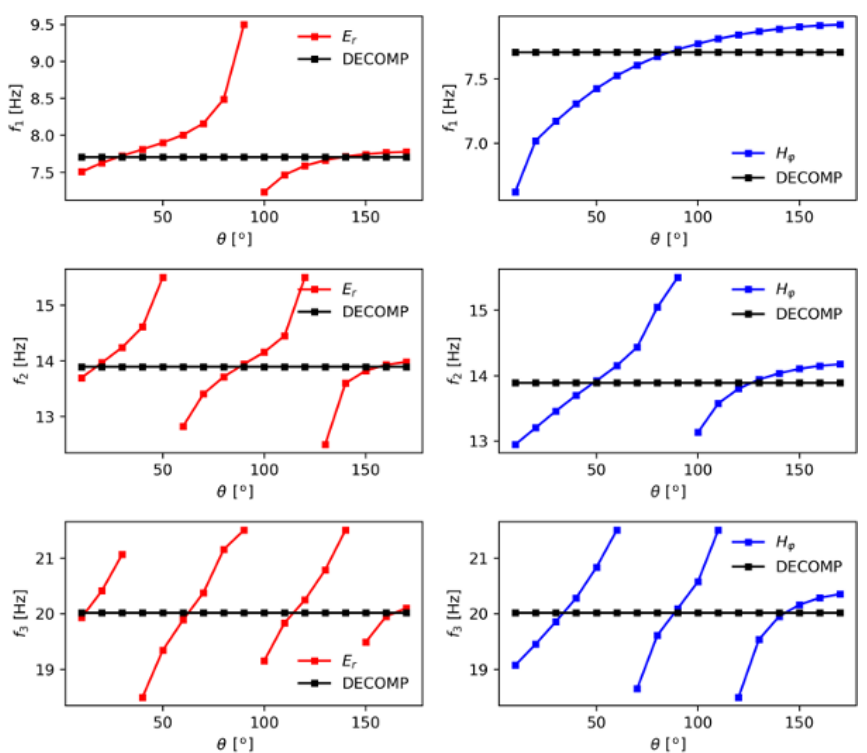
Figure 6. The Schumann resonance frequencies of the first three modes obtained at different source–observer distances and the resonance frequencies of the cavity obtained by the decomposition method (Kulak et al.,